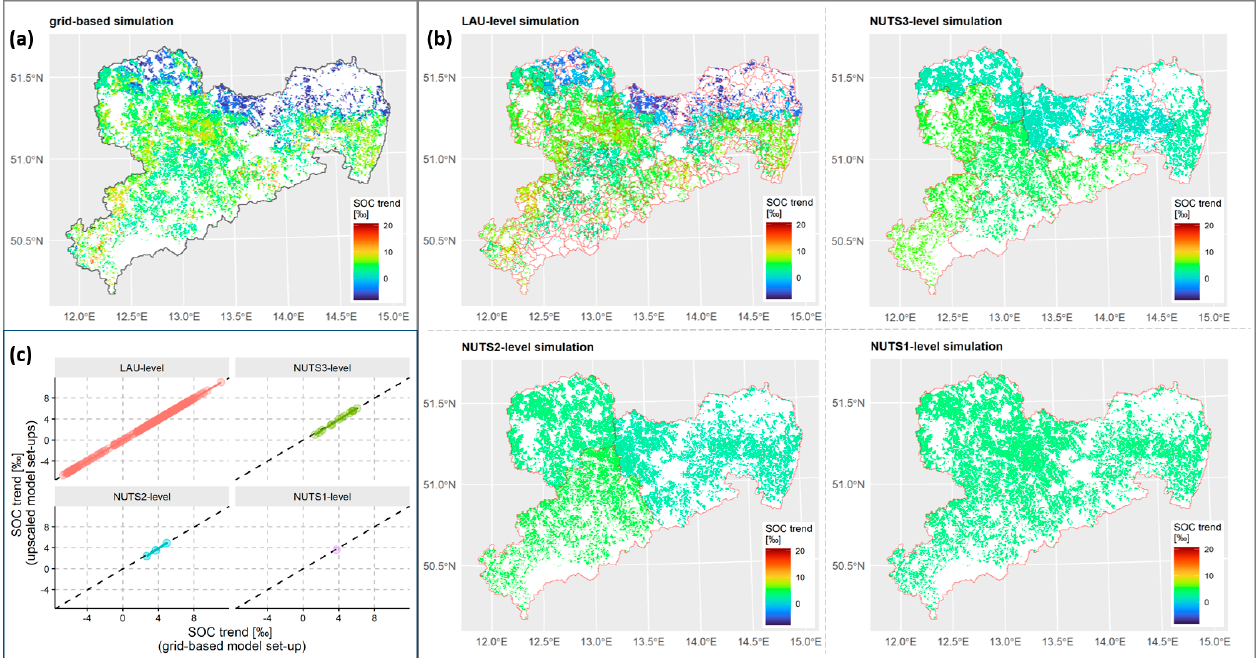
Figure 2. SOC trends (‰ per year based on SOC stocks of 1998) of the case study area Saxony (NUTS1 region in Germany) simulated with five different levels of data aggregation for the period 1998–2014. ( a ) Results of the grid-based reference simulation (29,319 grid cells). White areas represent non-arable land. ( b ) Results of the simulations using upscaled model set-ups on the level of administrative units (NUTS1, NUTS2, NUTS3, and LAU). ( c ) Scatter plots comparing results of the upscaled and the (grid-based) reference model set-up on the level of the individual administrative units (NUTS1: n = 1; NUTS2: n = 3; NUTS3: n = 13; LAU: n = 414). ©EuroGeographics for the administrative boundaries.